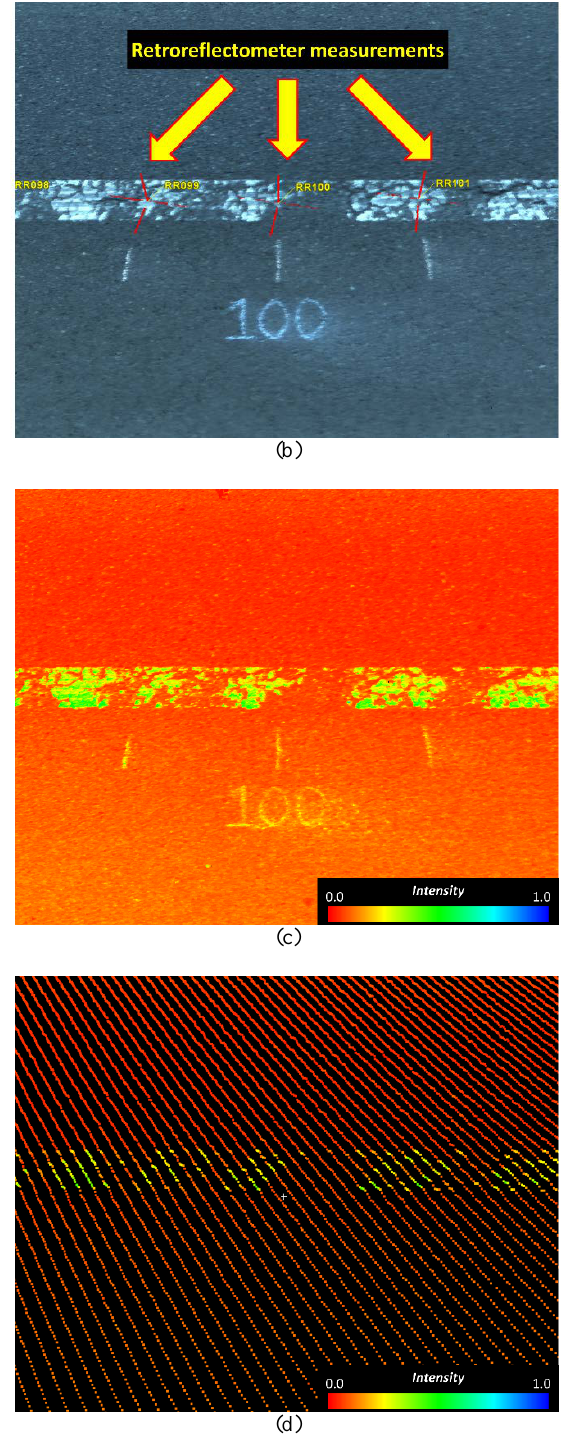
Figure 3. Examples of (a) photograph of a section of worn road marking, (b) RGB of the TLS point cloud and retroreflectometer samples, (c) Intensity of the TLS point cloud, (d) Intensity of the MLS point